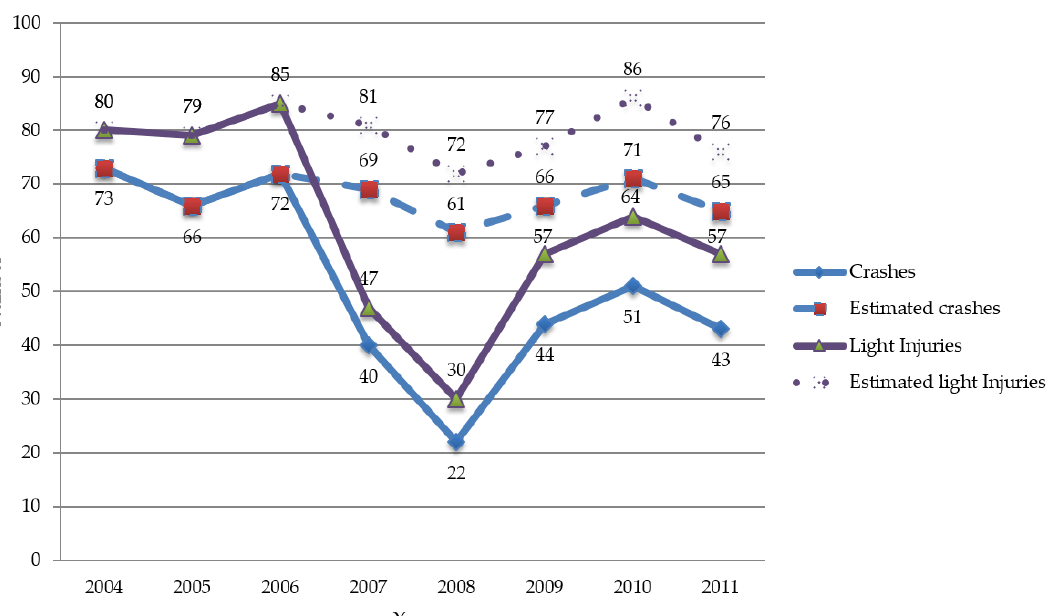
Figure 4. Comparison of crashes and light injuries with the estimated values of the control group (I).